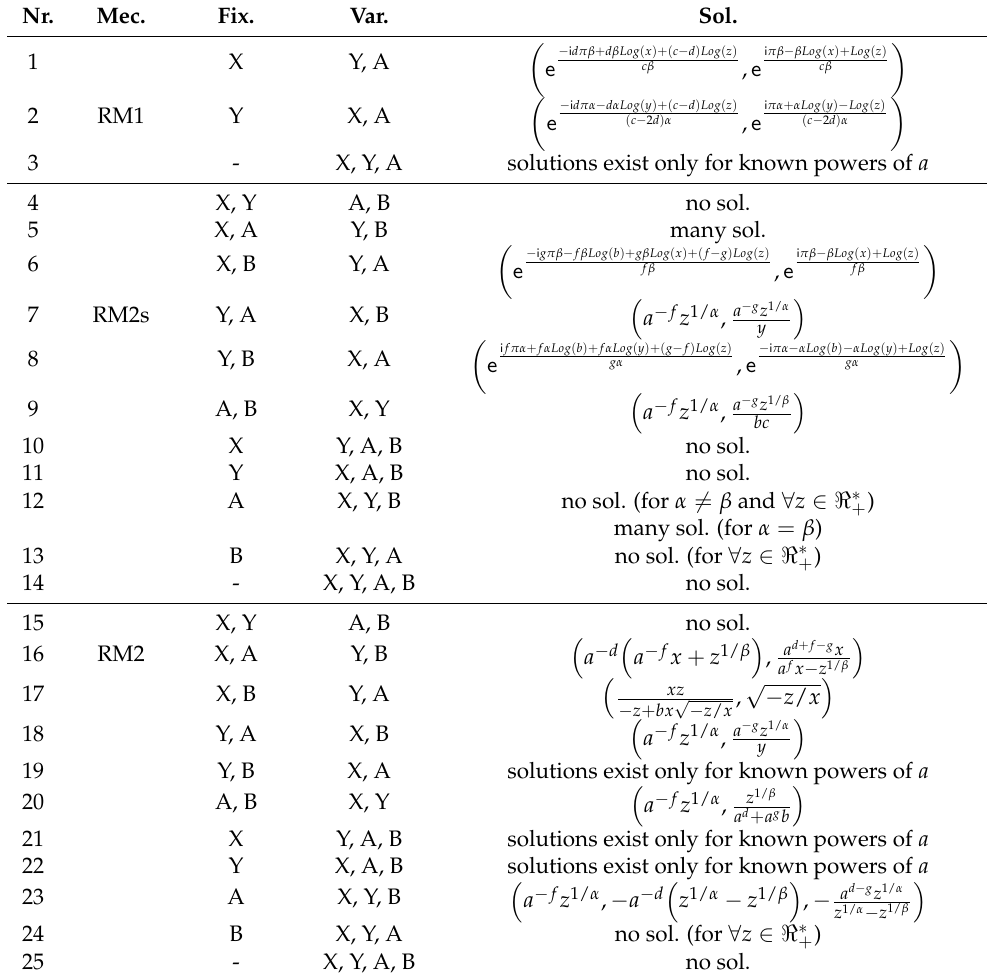
Table A3. Table of general solutions of the ODEs. Nr. Mec. Fix. Var.